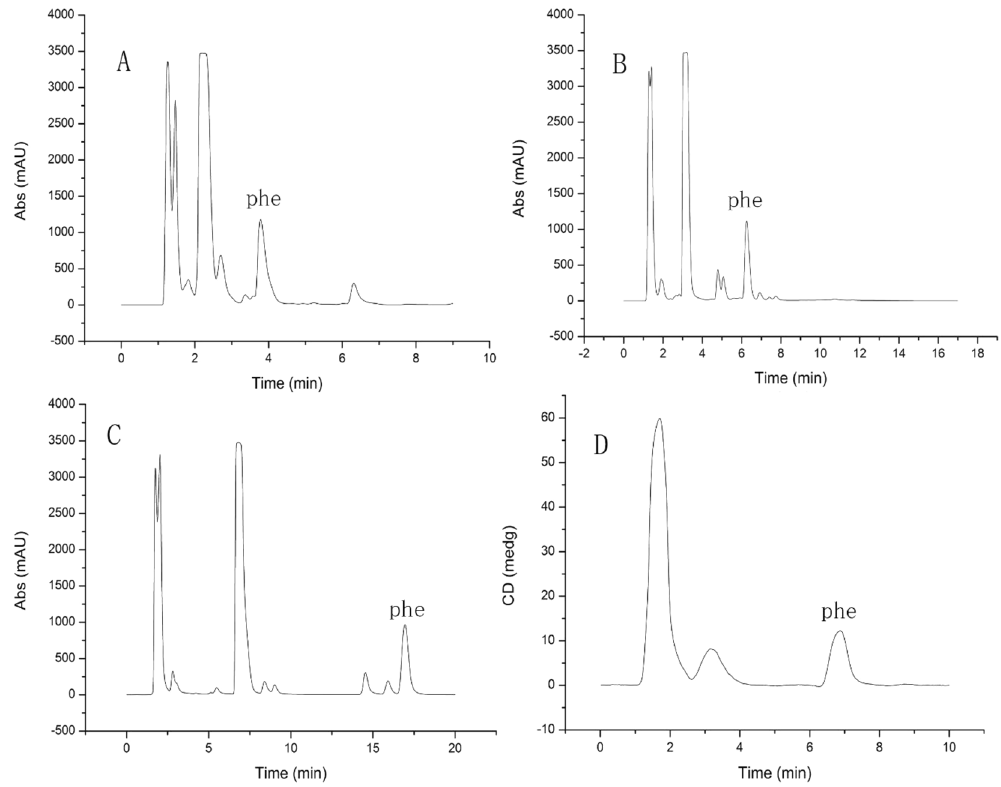
Figure 5. Separation of the L-phenylalanine from of the porcine insulin hydrolysate using different mobile phases. (Water: Acetonitrile = 95: 5 ( A ), 98:2 ( B , D ), 100:0 ( C ), DAD detector with a wavelength of 220 nm; ( D ): CD detector with a wavelength of 216.5